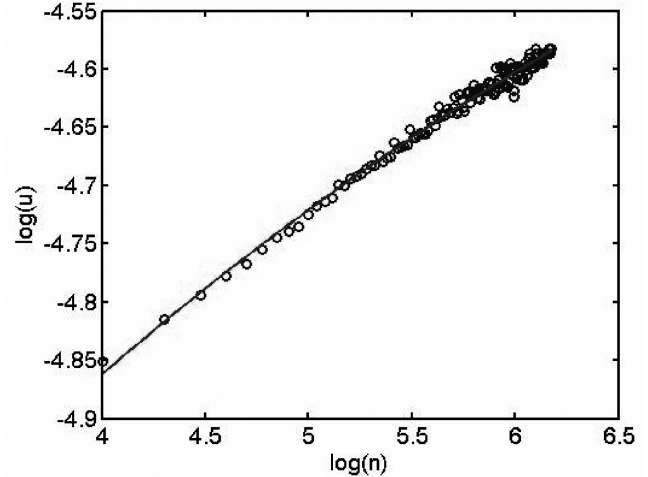
Fig. 8. Common logarithms of fi tted location parameters as a function of common logarithms of the normalized time intervals. The computation time increment Δ t is 120 μ s. Each signal contains n = 1.5 × 10 6 points. Therefore, the duration of each excitation is 180 seconds. The response to each excitation governed by Eq. (3), with parameters listed in Table 1, was computed using the Runge-Kutta approach. Figure 6 is a plot of displacement response in the time domain. Peak values from Eq. (8) were de fi ned for time intervals of duration T k = 1.2 k seconds, where k = 1, . . . , 150. In the ten signals, there are 1500 intervals of duration T 1 = 1.2 seconds, 750 intervals of duration T 2 = 2.4